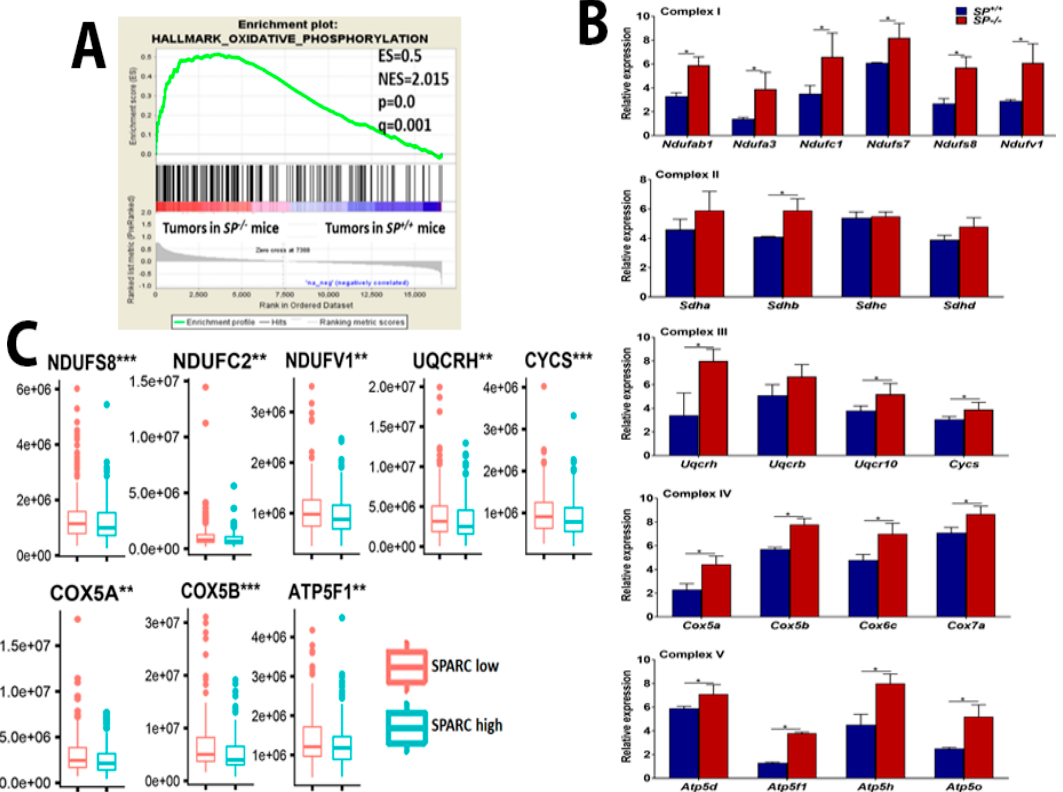
Figure 5. Effect of SPARC on mitochondrial electron transport chain (ETC). ( A ) Gene Set Enrichment Analysis (GSEA) of the top upregulated genes in whole transcriptome of ID8 tumors grown in SP − / − compared to SP +/+ mice showing the enrichment of oxidative phosphorylation and reactive oxygen species in tumors from SP − / − mice. ( B ) Bars represent mean ± SEM of the transcript levels of the indicated mitochondrial ETC enzymes determined by qRT-PCR, n = 3/genotype each in triplicates. * p < 0.05, Student’s t -test. ( C ) Human HGSC data sets from TCGA were stratified based on SPARC transcript level as SPARC-low and SPARC-High. The levels of the indicated enzymes were compared between SPARC-low and SPARC-High groups as described in the material and methods. ** p < 0.01 and *** p < 0.001.